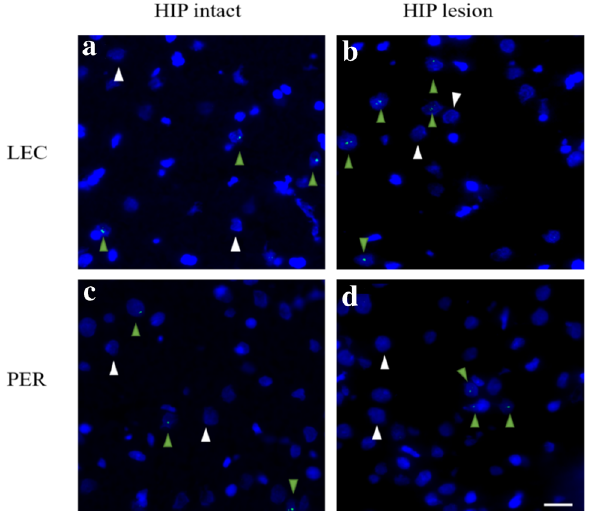
Figure 3. Representative images of Arc RNA expression in LEC and PER during memory retrieval in HIP intact and HIP lesioned groups. Lesioning HIP enhances the percentage of Arc positive cells in LEC ( a vs b ), while it has no significant effect in PER ( c vs d ). DAPI-stained nuclei are shown in blue. Arc intranuclear signal in green. Green arrowheads show Arc positive cells. White arrowheads show Arc negative cells. Scale bar 20